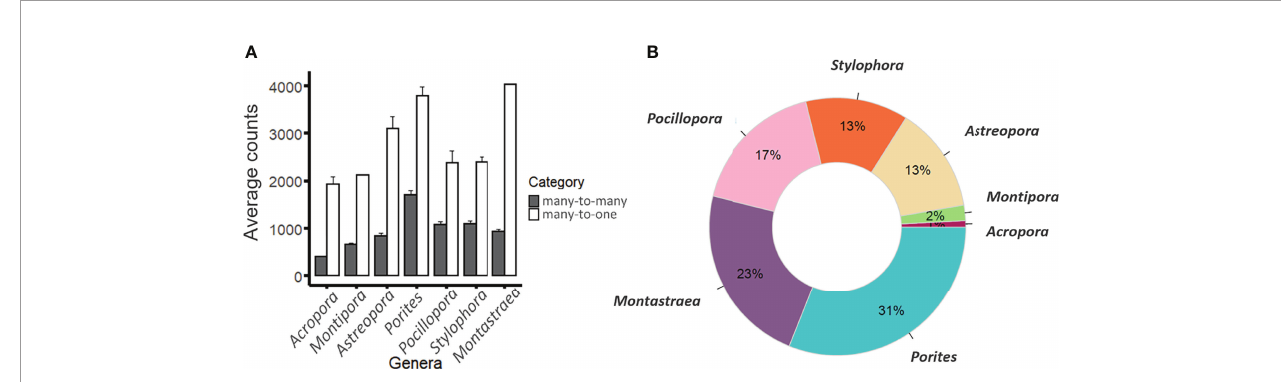
FIGURE 1 | Classi fi cation of genomic protein sets. (A) Average counts of genes assigned to many-to-many (grey bars) or many-to-one (white bars) orthogroups across the coral genera examined ( sensu Voolstra et al., 2017). Note that most genera consisted of one species except for Montipora (2), Pocillopora (2) species, and Acropora (16). Error bars denote standard error. (B) Average proportions of species-speci fi c orthogroups within each